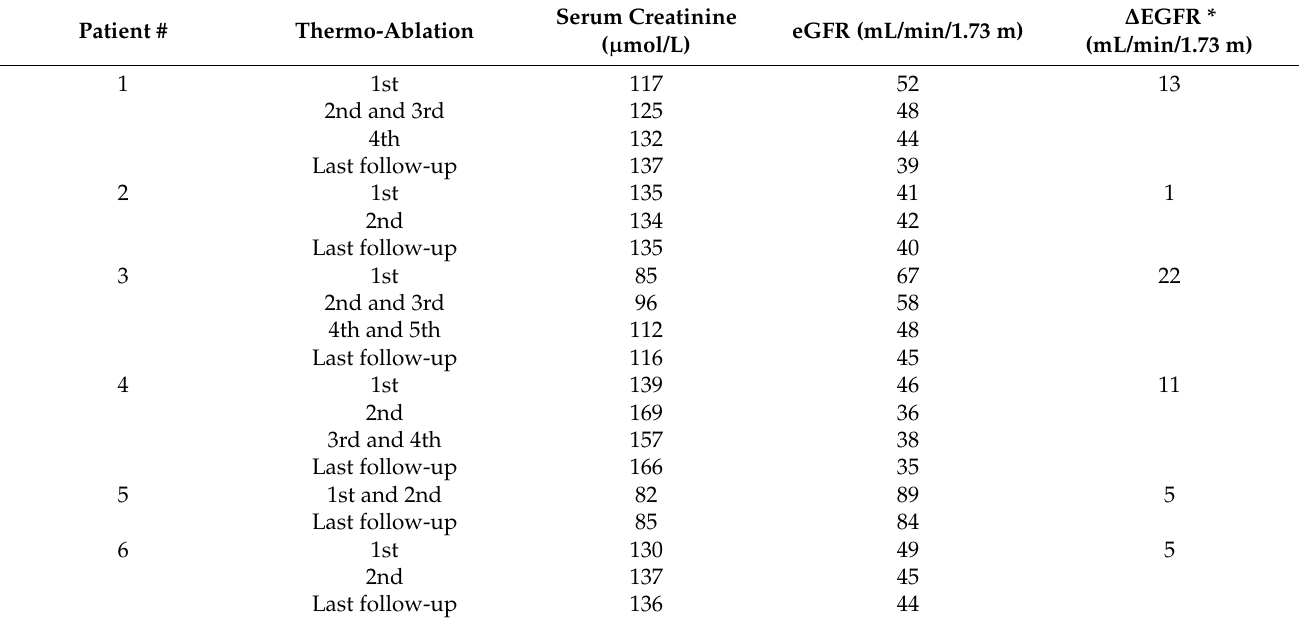
Table 4. Evolution of the renal function of the six patients after each thermal ablation